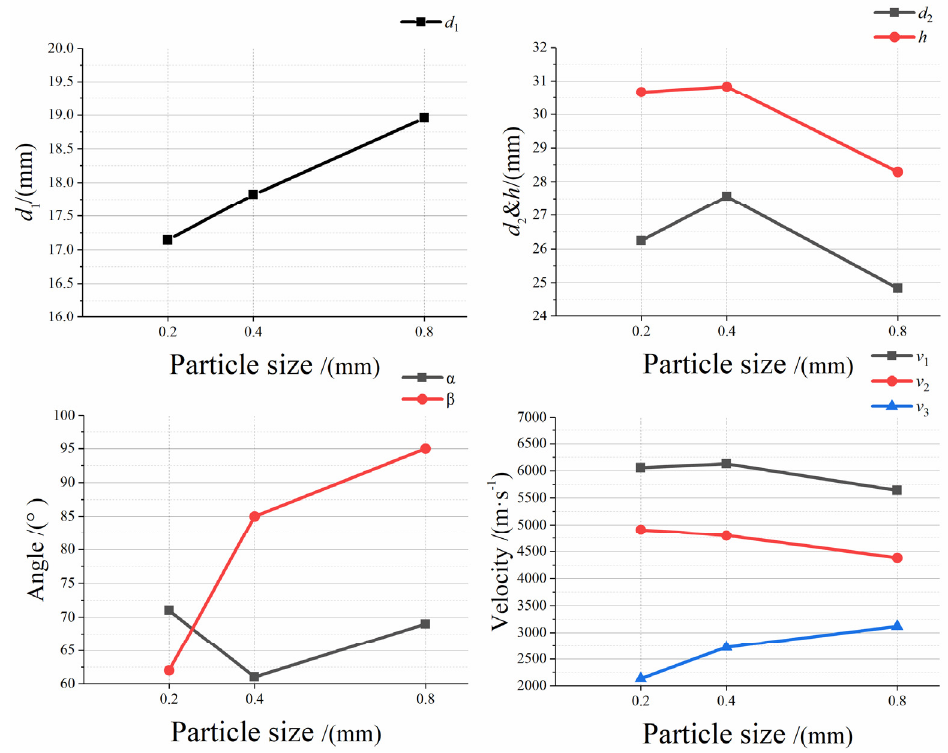
Figure 17. Curves of characteristic parameter values under different mesh sizes.